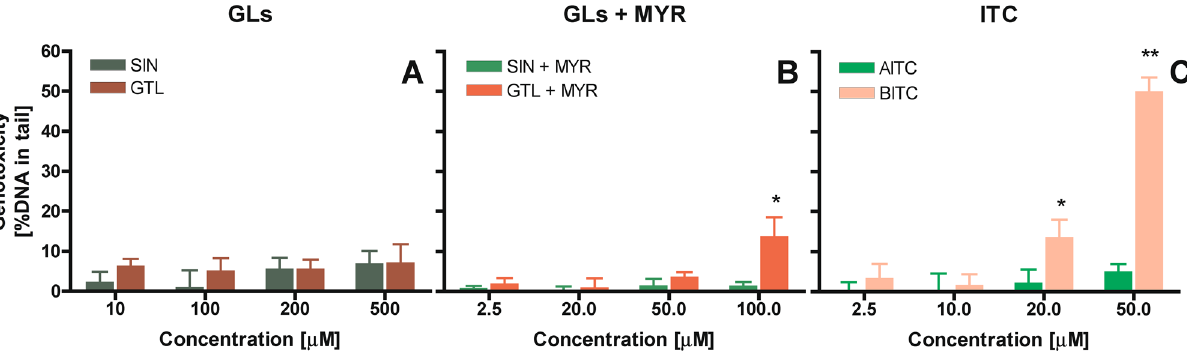
Figure 5. Genotoxic effect in HT29 cells determined for ( A ) glucosinolates (GLs)—sinigrin (SIN) and glucotrapeolin (GTL); ( B ) glucosinolates in the presence of myrosinase (SIN/GTL + MYR) and ( C ) released upon GLs hydrolysis isothiocyanates (ITC)—allyl isothiocyanate (AITC) and benzyl isothiocyanate (BITC). As negative control served the cells treated with pure water instead of tested compounds (± 5% DNA in tail); as positive control served the cells treated with 100 µM H 2 O 2 (± 80% DNA in tail). The results represent means ± SD of three independent determinations. Significantly different values determined by one-way analysis of variance (ANOVA) with Dunnett’s post-test are marked as *p < 0.05, **p <